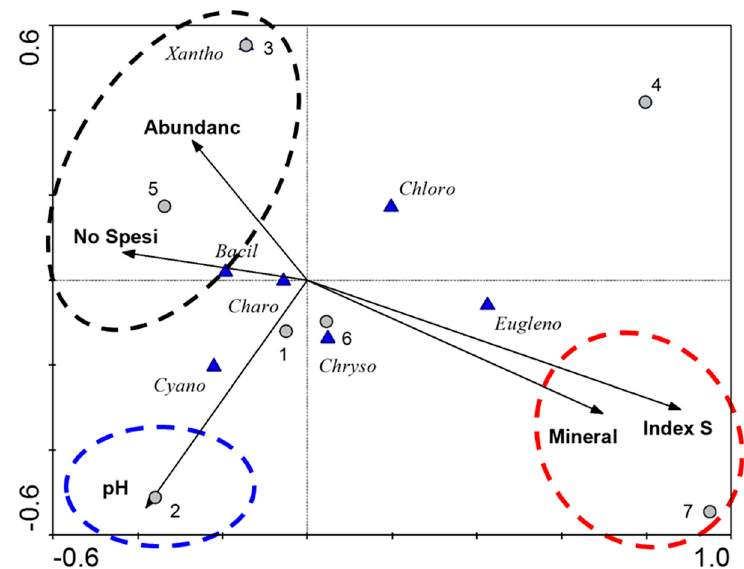
Figure 9. Canonical correspondence analysis (CCA) plot for relationships between biological and environmental variables in studied sites of the bogs of the Ershov oil field in the Vakh River basin of the KMAO-Yugra.